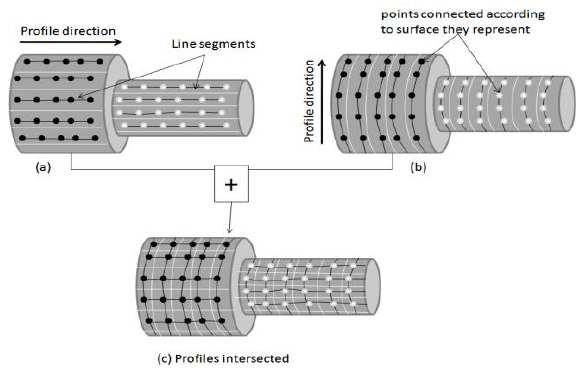
Figure 2. Segmentation by profile intersection: (a) and (b) show two different stacks on a pipe, (c) Profiles are intersected to obtain